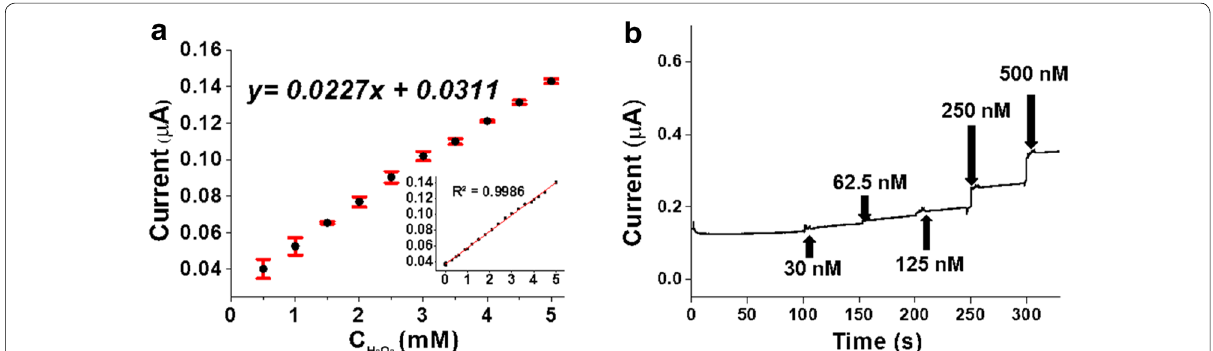
Fig. 5 a Calibration curve of 0.5 mM concentration of H 2 O 2 versus catalytic peak current and error bar with trend line equation and linear range (0.00025–5.0 mM) with a correlation coefficient of 0.9986; b amperometric response curves of Hb/DNA/NPGF addition of 30 nM, 62.5 nM, 125 nM, 250 nM and 500 nM H 2 O 2